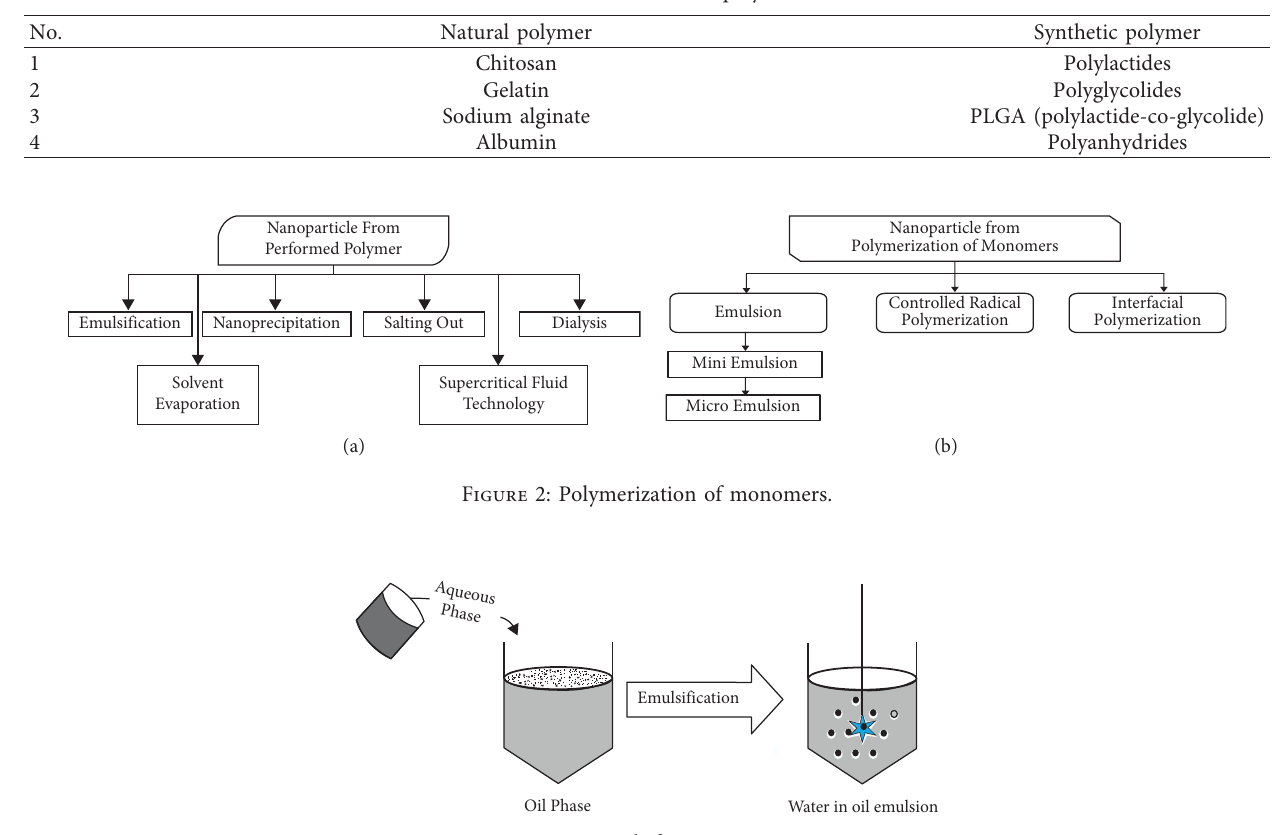
Figure 3: Emulsification process.